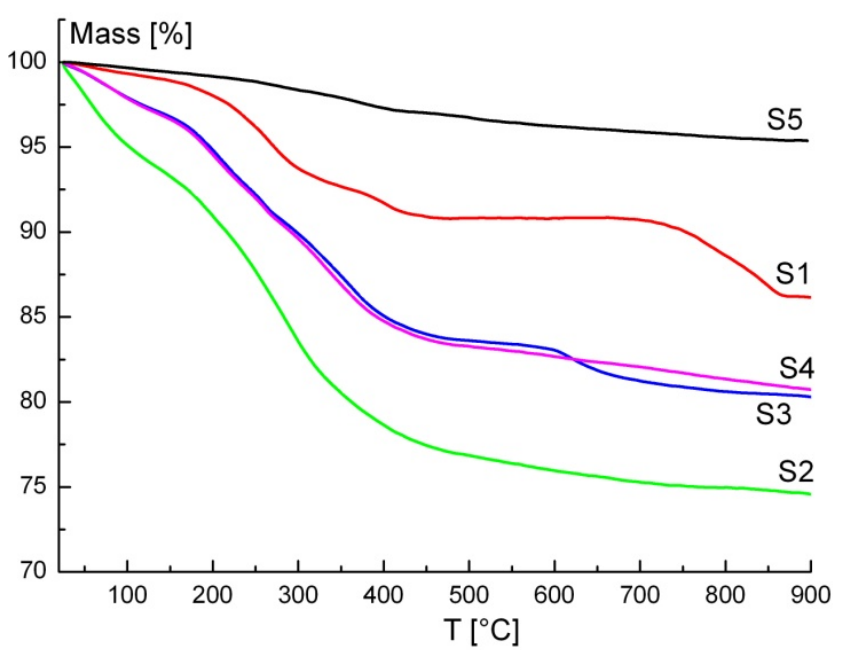
Figure 5. TG curves of obtained samples.